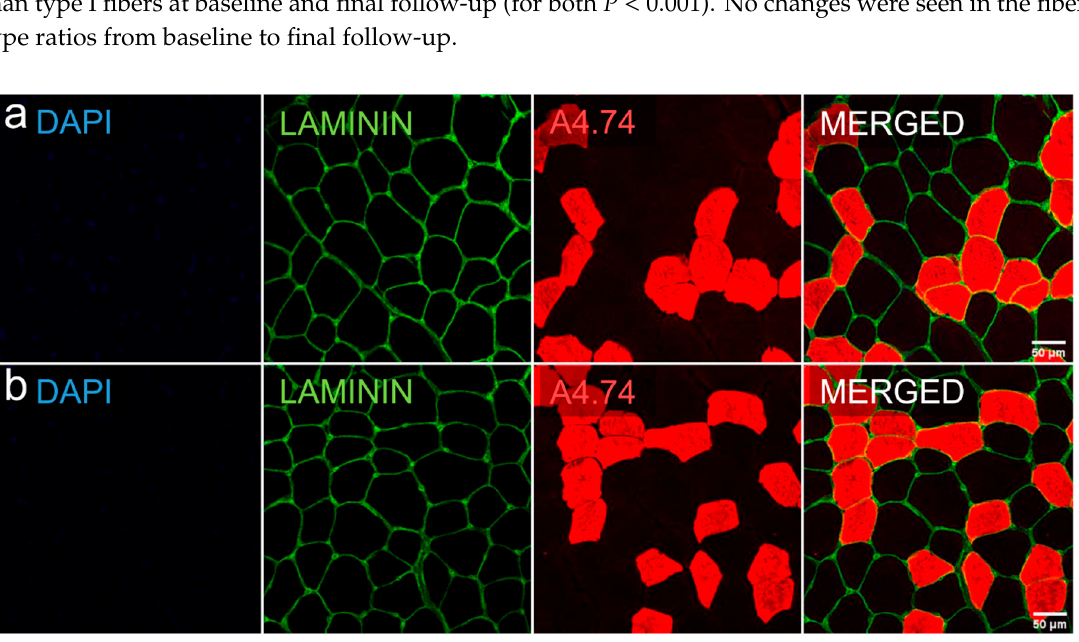
Baseline Final follow-up Myosin isoform n = 25 n = 25